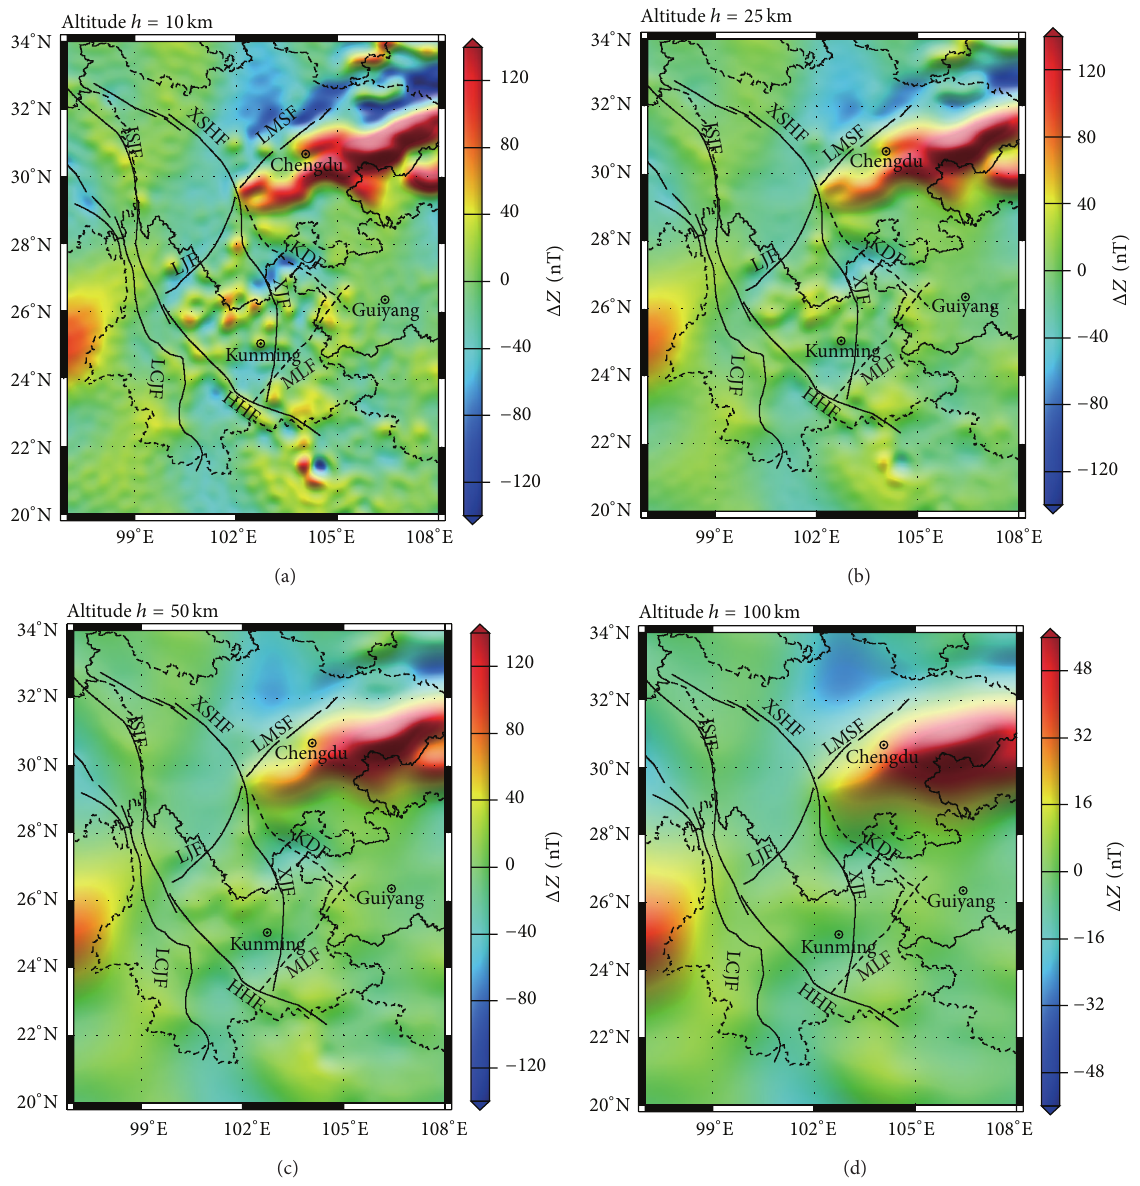
Figure 3: Distribution of the crustal magnetic anomaly at different altitudes: (a) 10km; (b) 25 km; (c) 50 km; and (d) 100km.